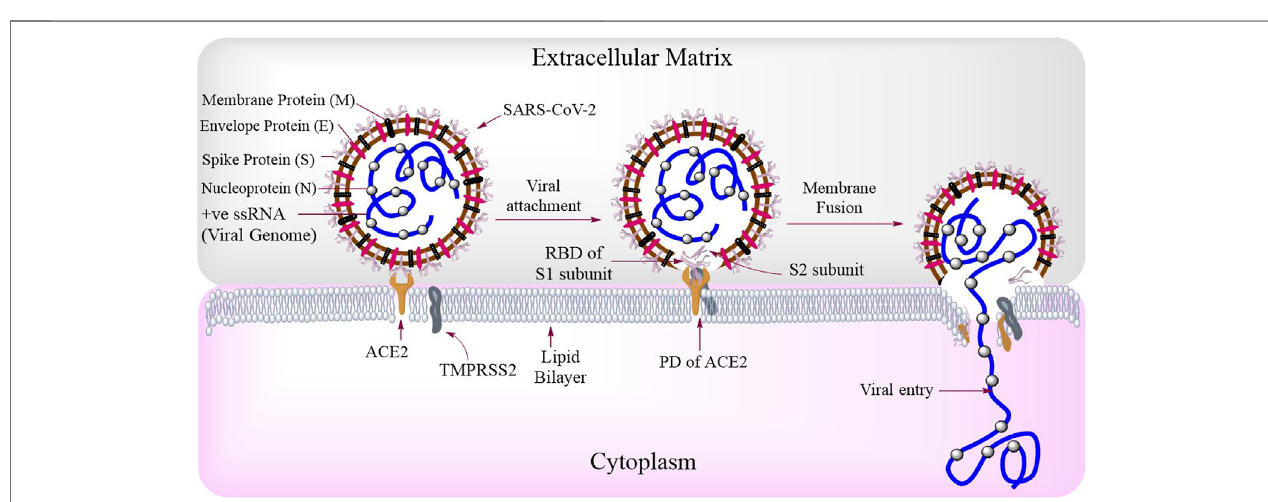
FIGURE 2 | SARS-CoV-2 structure and routes of entry: SARS-CoV-2 consists of Spike protein (S) membrane protein (M), envelope protein (E), nucleoprotein (N), and the viral genome (+ve ssRNA). Among these, the S protein is most important and ismade up of two types of subunits that is, S1 (for binding with host receptor) and S2(forviralfusion) subunits.Duringviralattachment,thereceptor-binding domain(RBD)ofS1interactswiththepeptidasedomain (PD)ofACE2.Theentryandfusionof this virus is aided by a transmembrane serine protease,